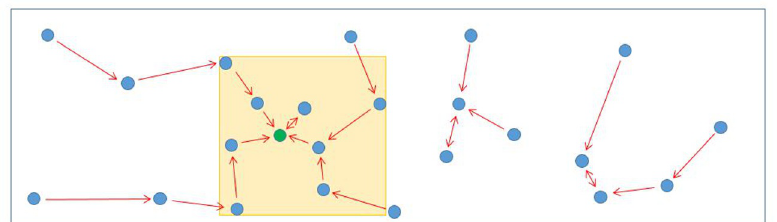
Figure 4 . Graphical description of the clustering algorithm used for box initialization with Algorithm 1. Blue points indicate the position of events in the two shown variables of the feature space. Arrows pointing from an event to another indicate the location of the closest neighbour of the event originating the arrow (according to a metric described in the text). The green point is the closest to four others, and it provides the seed of the box: the collection of all events which point to those four events define the boundaries of the